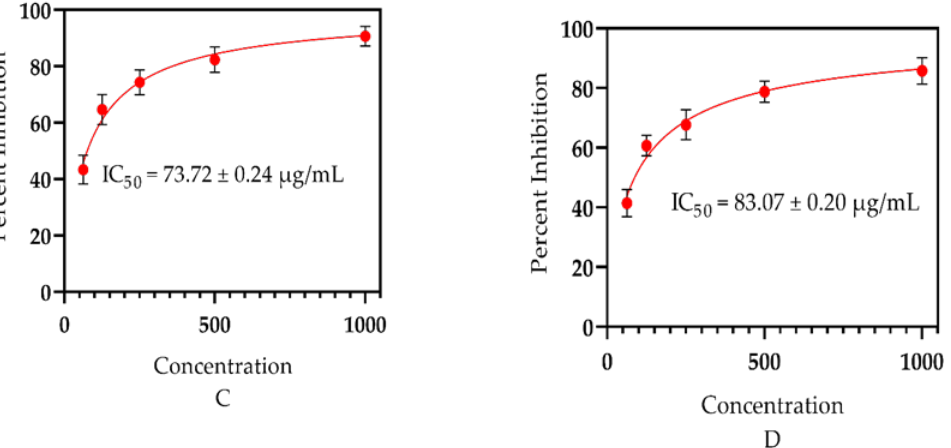
Figure 5. ( A ) Antioxidant significance of ELEO using DPPH assay, ( B ) antioxidant capability of E. larica essential oil via ABTS assay, ( C ) antioxidant effect of the standard ascorbic acid via DPPH, and ( D ) antioxidant activity of the standard via ABTS